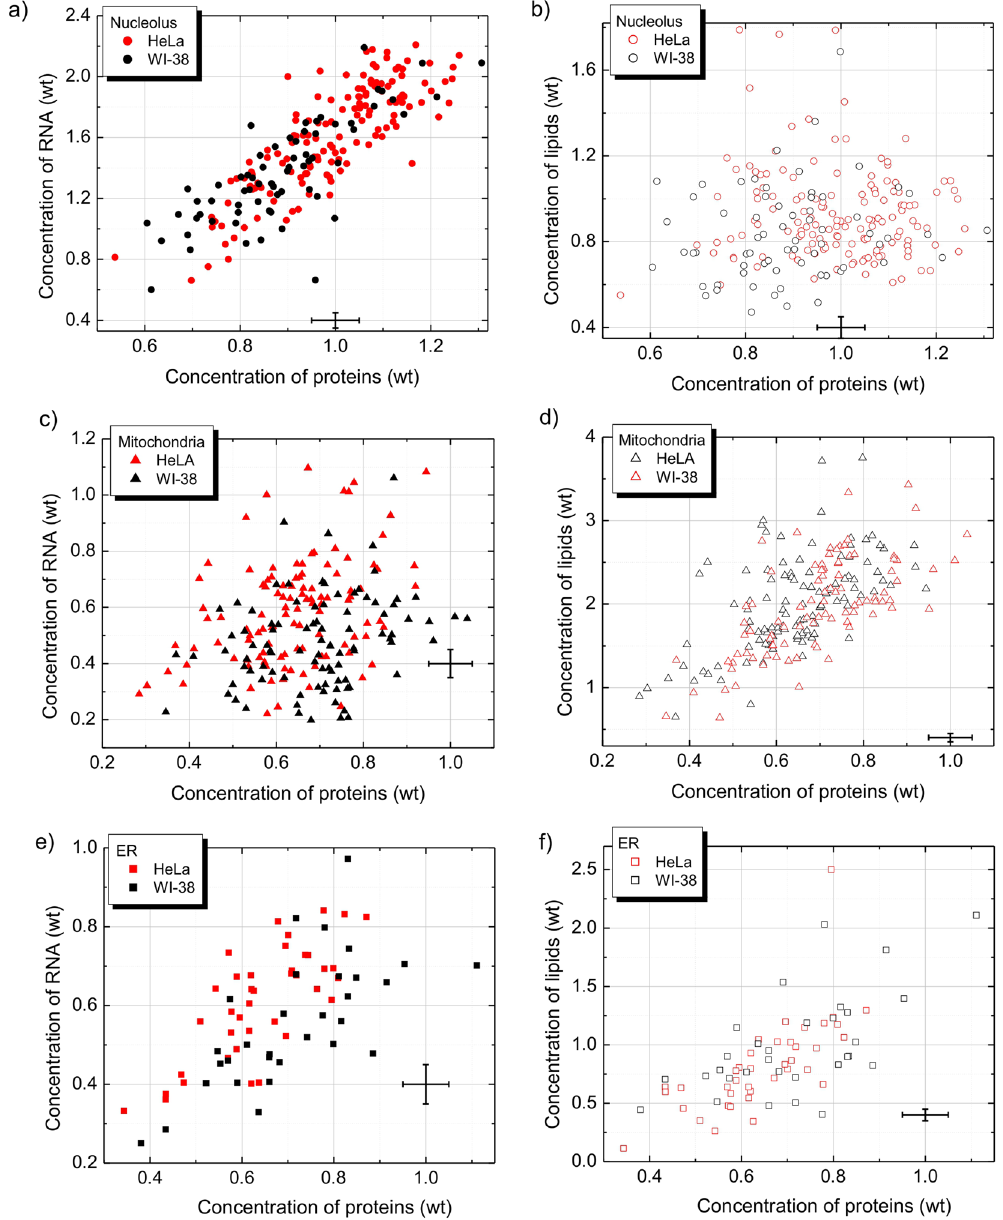
Figure 2. Concentrations of lipids and RNA versus concentrations of proteins in the nucleoli ( a , b ), mitochondria ( c , d ) and ER ( e , f ). Plots represent a distribution of molecular profiles in single cells. Bold symbols – RNA vs proteins, open symbols – lipids vs proteins, red symbols – WI-38, black symbols – HeLa. Standard deviations are shown as error bars. Concentration weight unit corresponds to 100 mg/ml for proteins, 20 mg/ml for RNA and